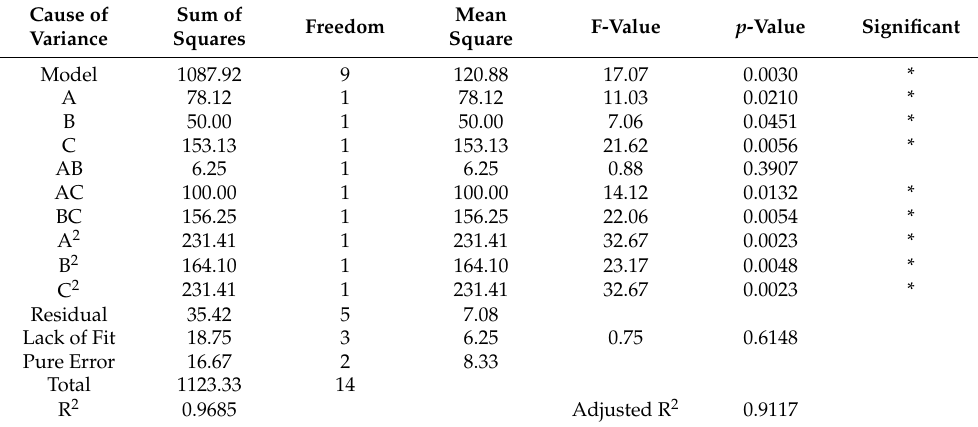
Table 5. ANOVA of the picking